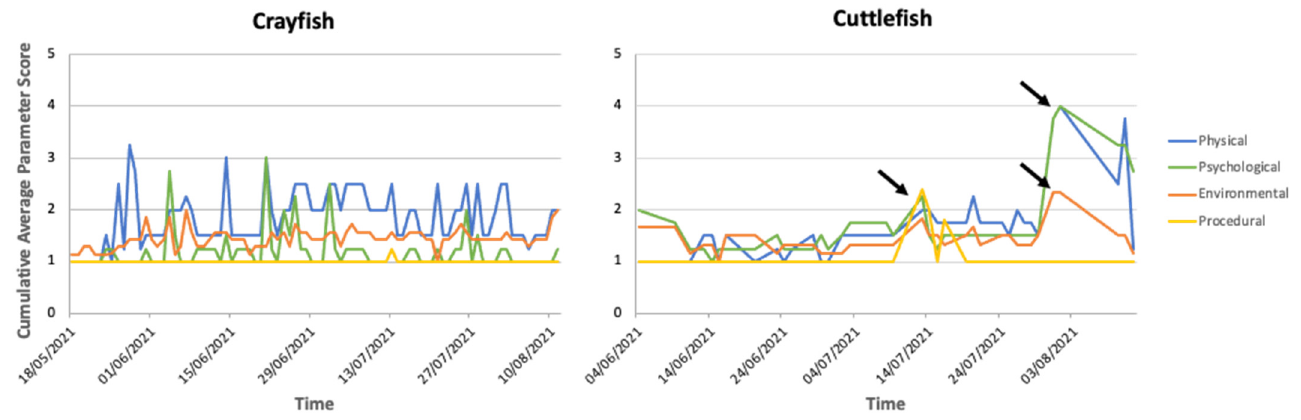
Figure 4. Daily average parameter welfare assessment scores over time for MZ crayfish. Each line presents one of the four assessed parameters: physical, psychological, environmental, procedural, on a scale of 1 to 10. In the figure, the axes are adjusted based on the range of the daily average parameter scores. The black arrows indicate the noticeable parameter changes between two events that incur greater (i.e., suboptimal) welfare scores presented with the cuttlefish assessment.